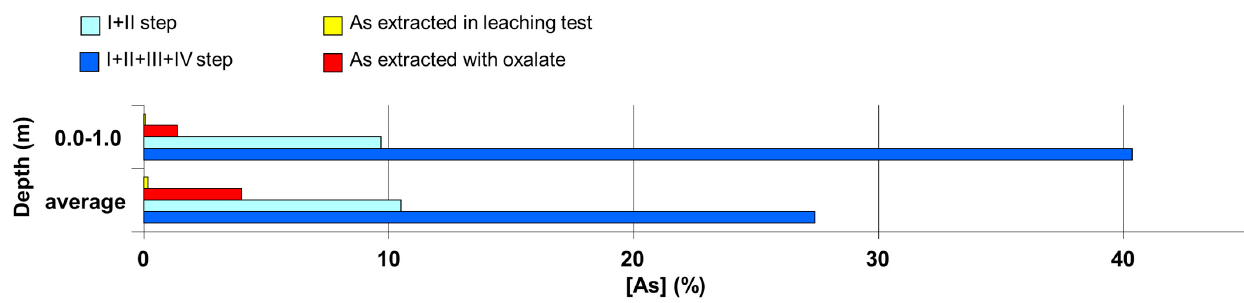
Figure 5. Comparison between the average percentage of As extracted for the leaching test, by ammonium oxalate, and in the first two steps and the first four steps of sequential extraction procedures for soil samples in the most superficial layer.